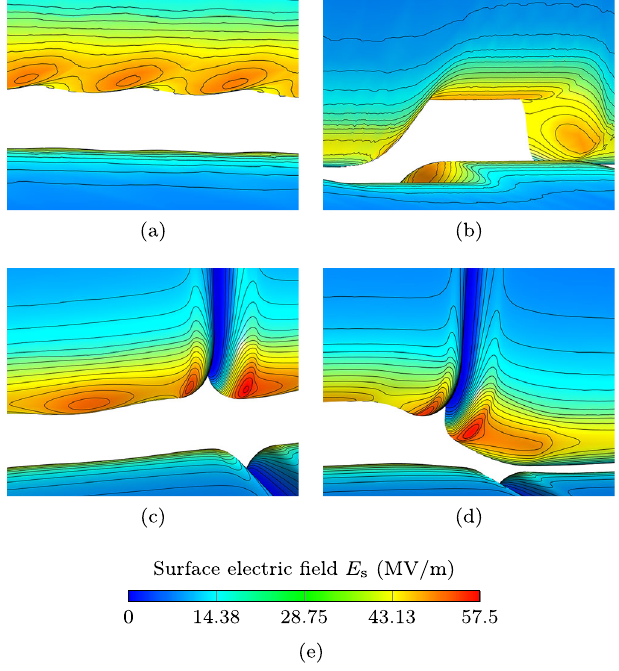
FIG. 27. Surface electric field in normal cells of bunching section (a) and accelerating section (b), as well as in cells interrupted by the inter-module gap in bunching section (c) and accelerating section (d), and (e)